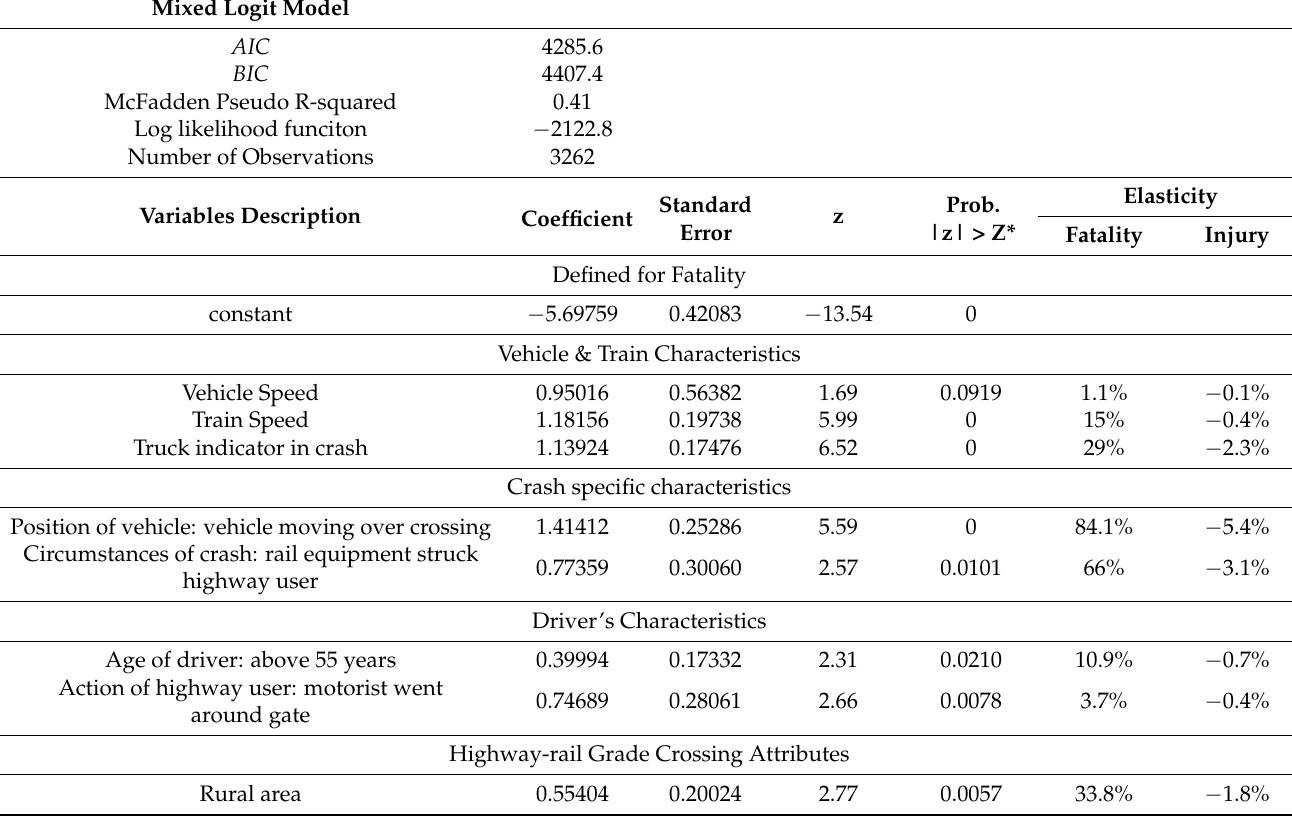
Table 3. Results of truck model (fatality).